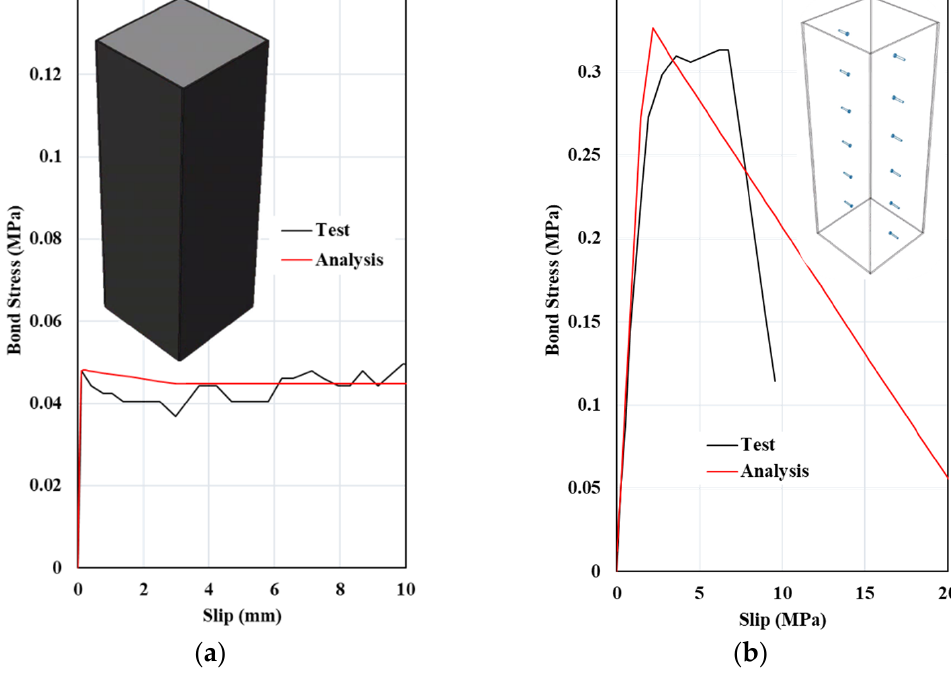
Figure 9. Comparison of test and finite-element method results: ( a ) square CFST without stud connectors and ( b ) square CFST with stud connectors.